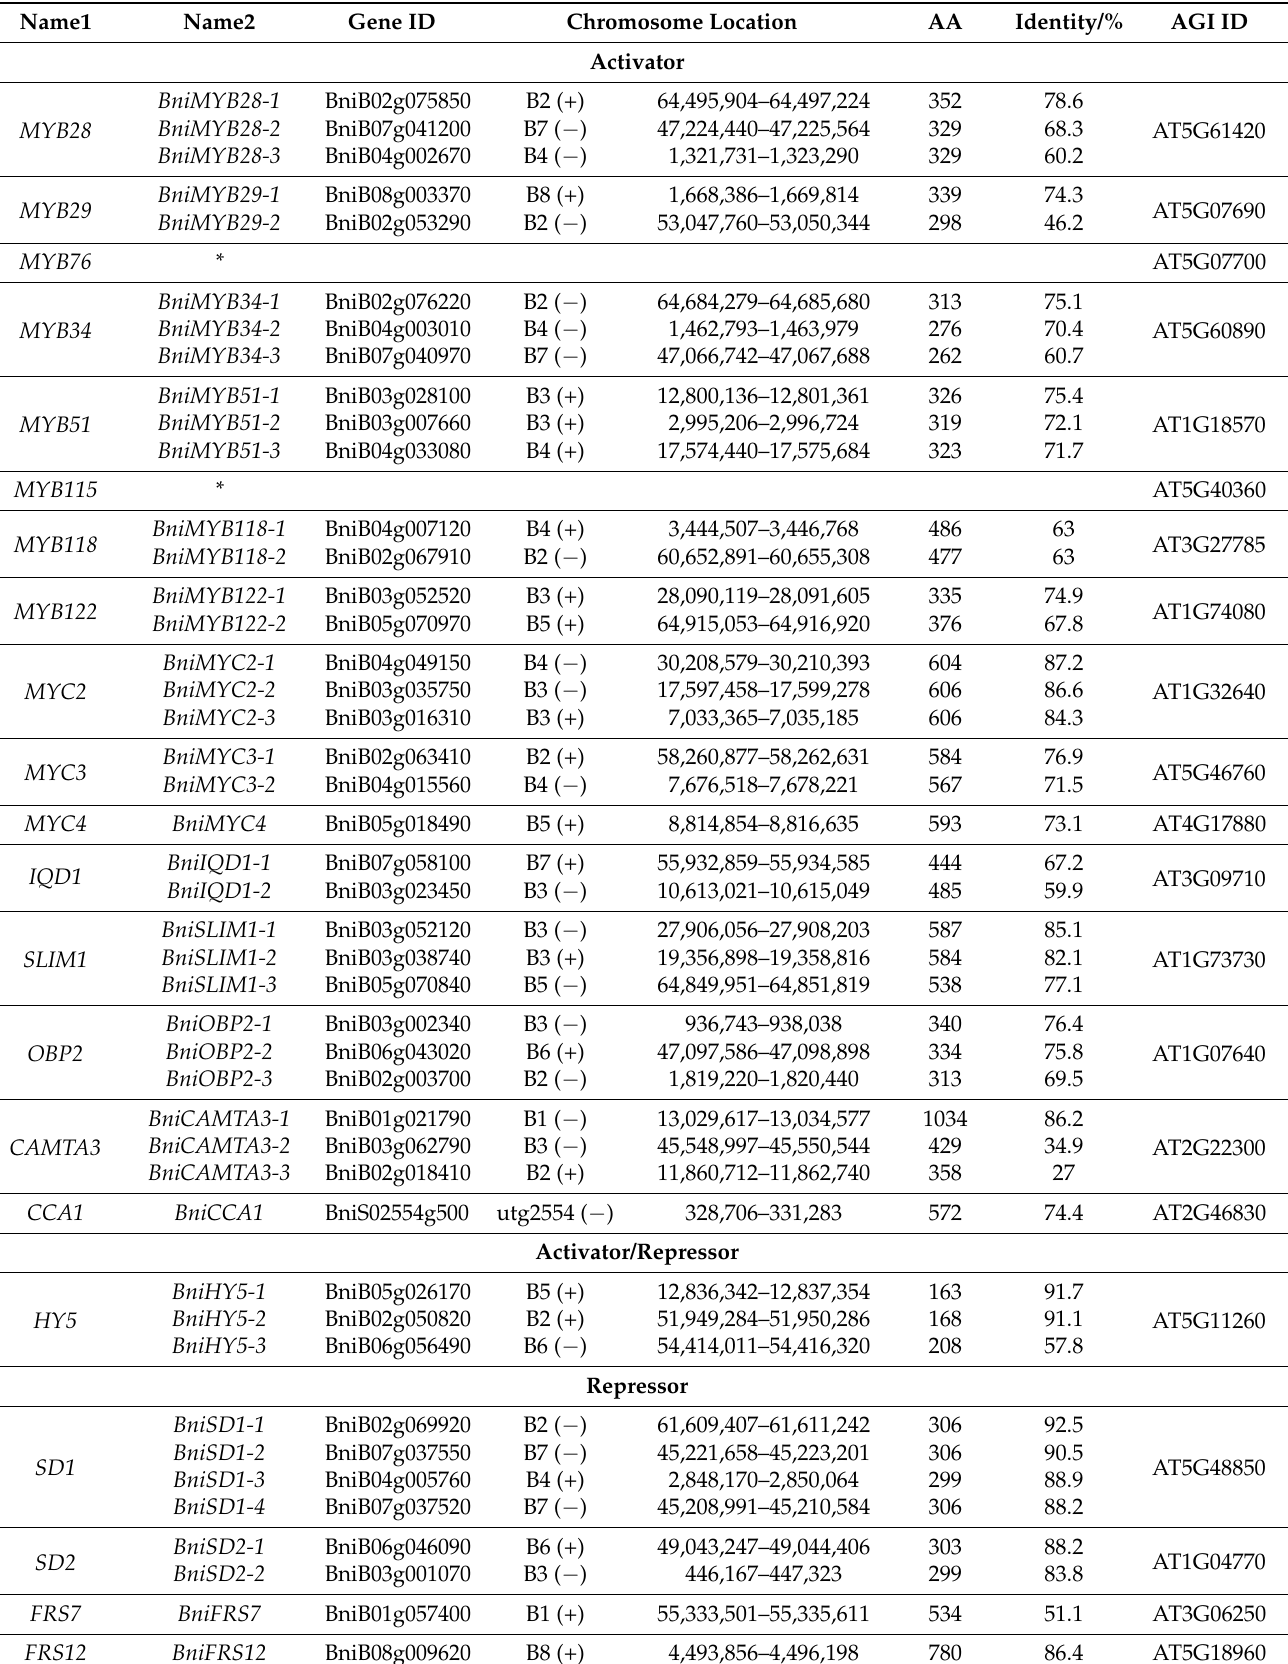
Table 3. The inventory of transcription factor genes and transporter genes involved in glucosinolate biosynthesis in Brassica nigra